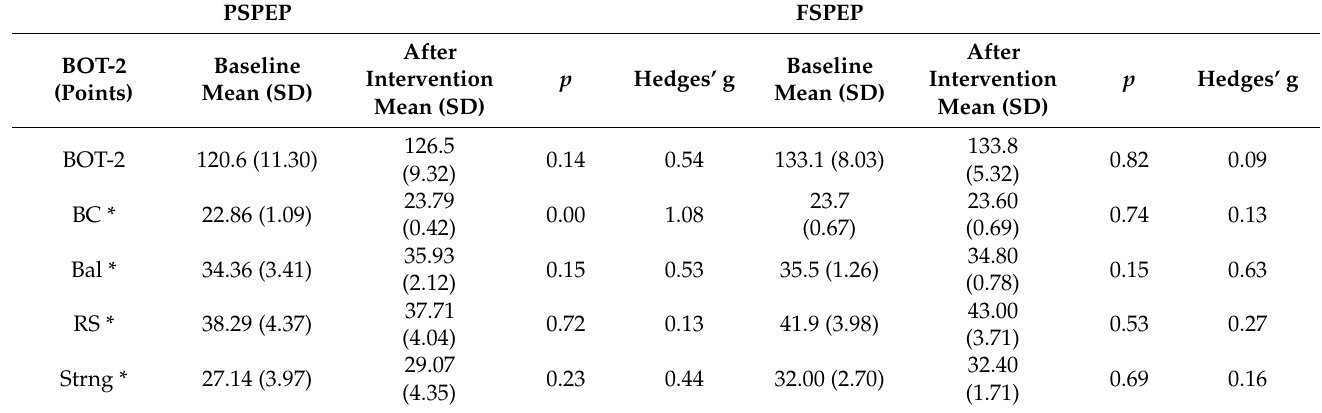
Table 3. BOT-2 test